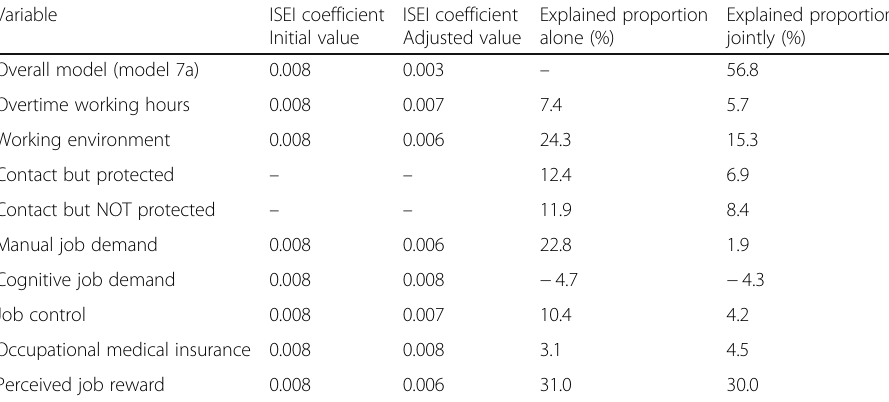
ISEI coefficient Explained proportion Explained proportion Initial value Adjusted value alone (%) jointly (%)